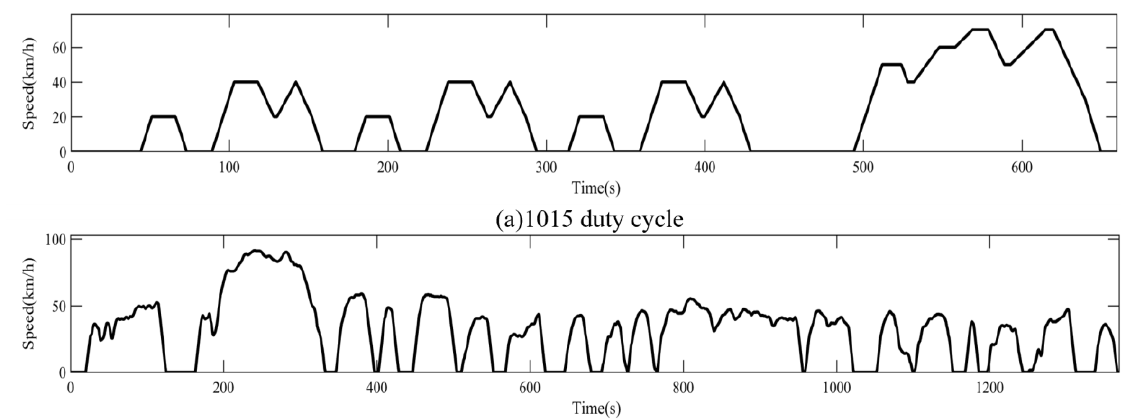
Figure 10. Duty cycles: ( a ) 1015; ( b ) UDDS.